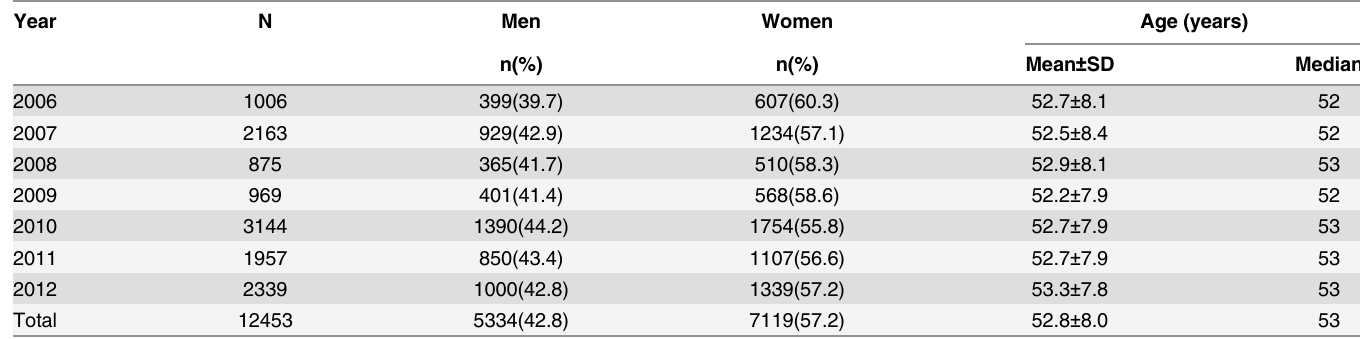
Table 1. General information on study subjects participating in the screening program during the period of 2006 – 2012 in Yangzhong.